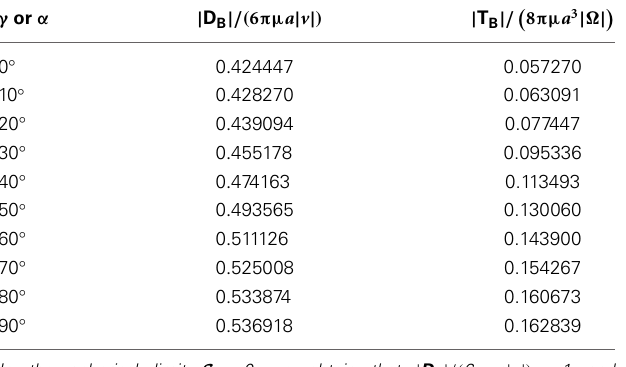
Table 1 | The scaled drag force and the scaled viscous torque as a function of γ and α for E = 0 . 96.